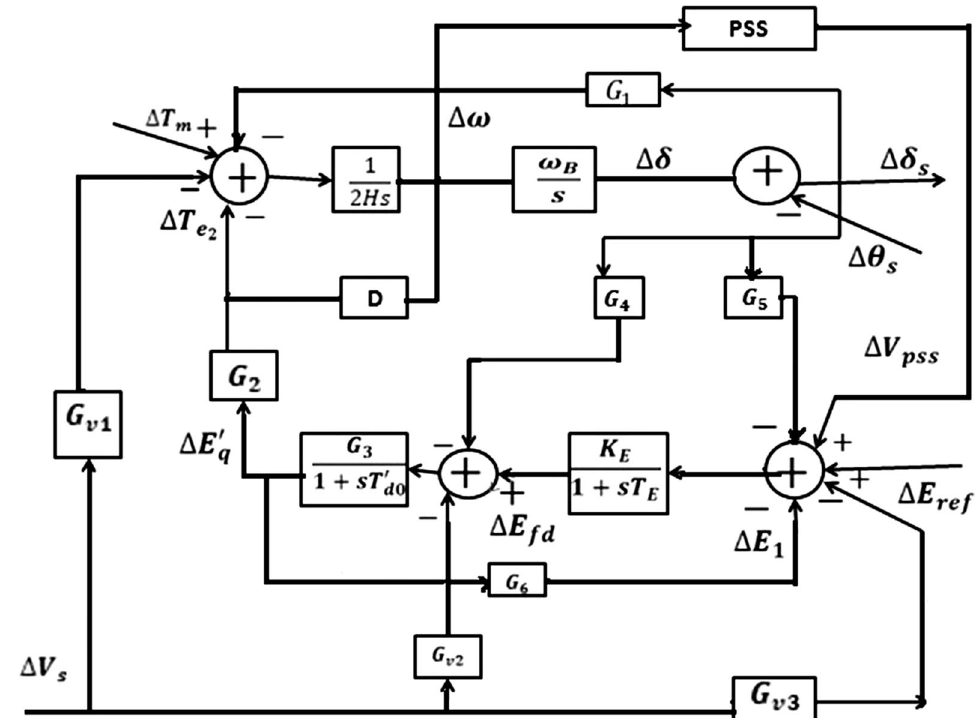
Fig. 2 Block diagram of the MHP model